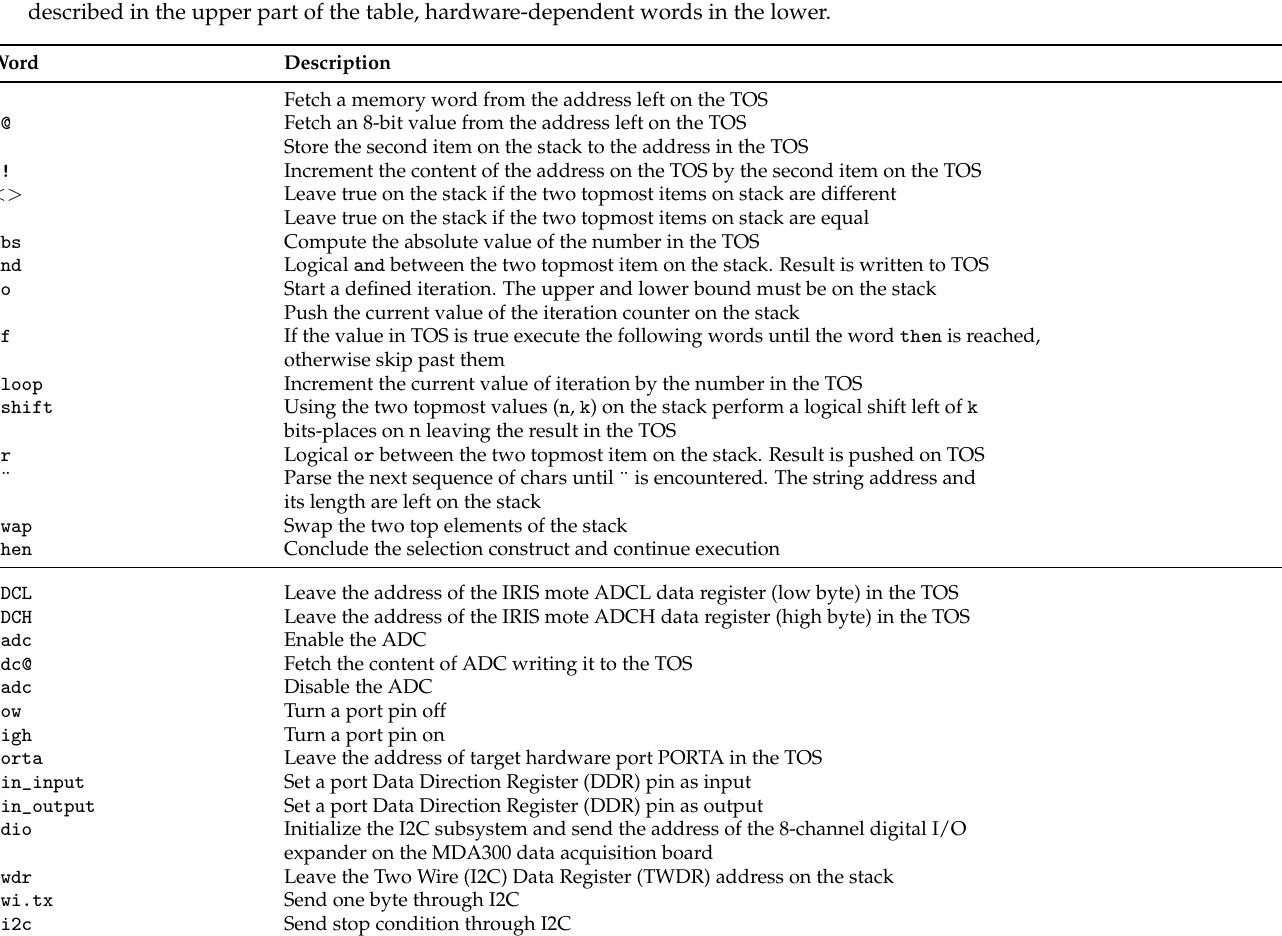
Table A1. Summary table of a subset of low-level words used by specification rules in Section 4.2. Standard Forth words are described in the upper part of the table, hardware-dependent words in the